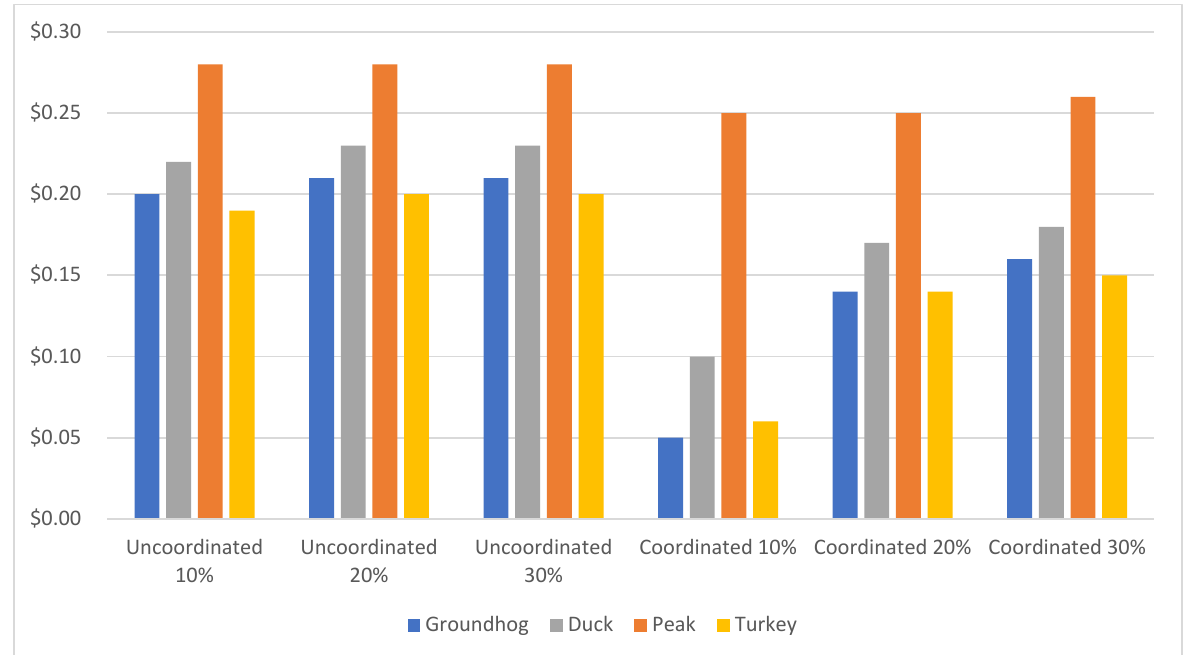
Figure 11. The average daily cost to charge an EV per scenario.